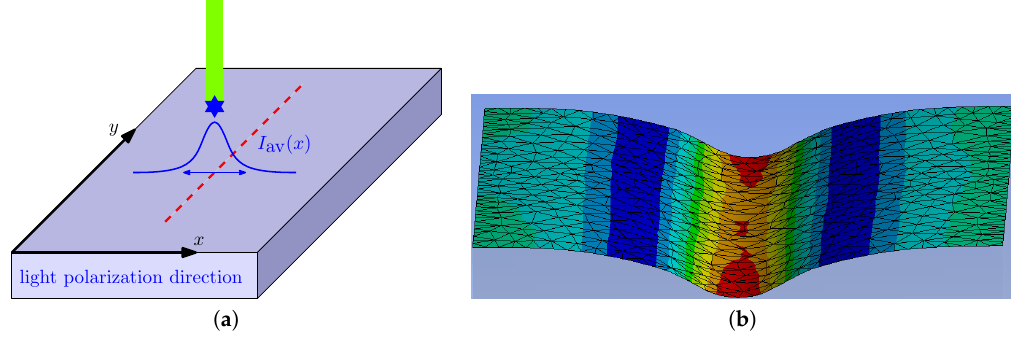
Figure 1. ( a ) The laser is moved (denoted with red dashes) in the y direction perpendicular to light polarization aligned along the x direction. ( b ) The deformations for the upper surface of the material in the presence of x polarized light. τ max = 50 MPa. The beam radius w = 2